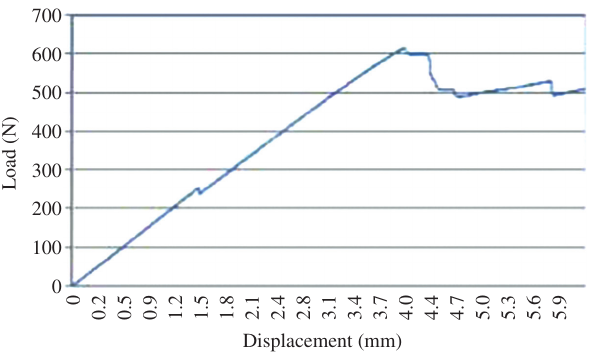
Figure 12 Load-displacement curve for [0 ° ] nate in ENF